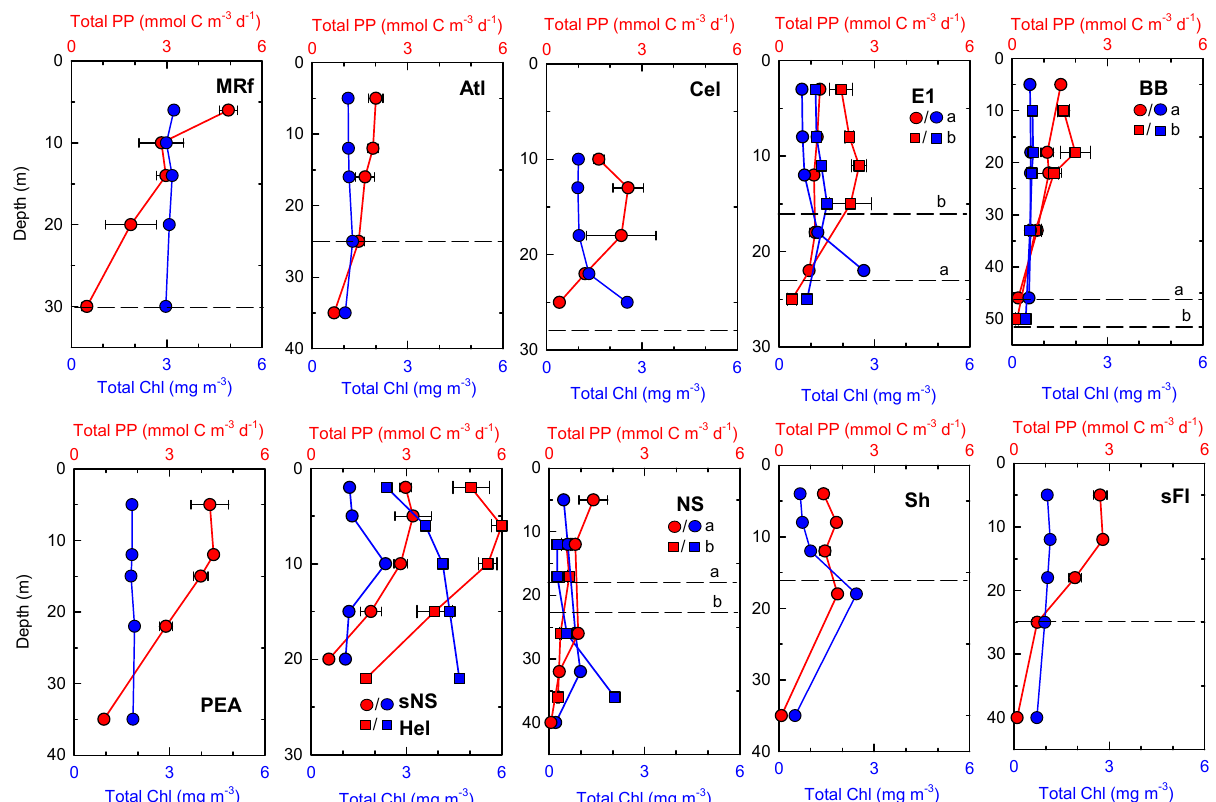
Figure 3. Vertical profiles of total primary productivity (total PP, mmolCm − 3 d − 1 ) and total chlorophyll (total Chl, mgm − 3 ) over the euphotic zone. Dashed lines indicate mixed layer